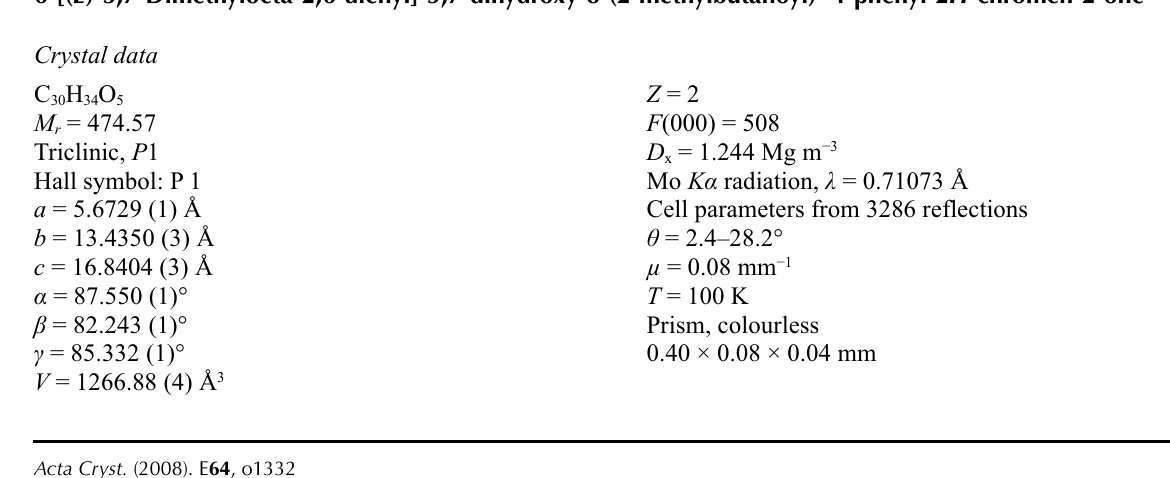
An ORTEP plot of the title compound, showing 70% probability displacement ellipsoids and the atomic numbering scheme. Hydrogen atoms are drawn as spheres of arbitrary radii. The two independent molecules are disposed over a false center of